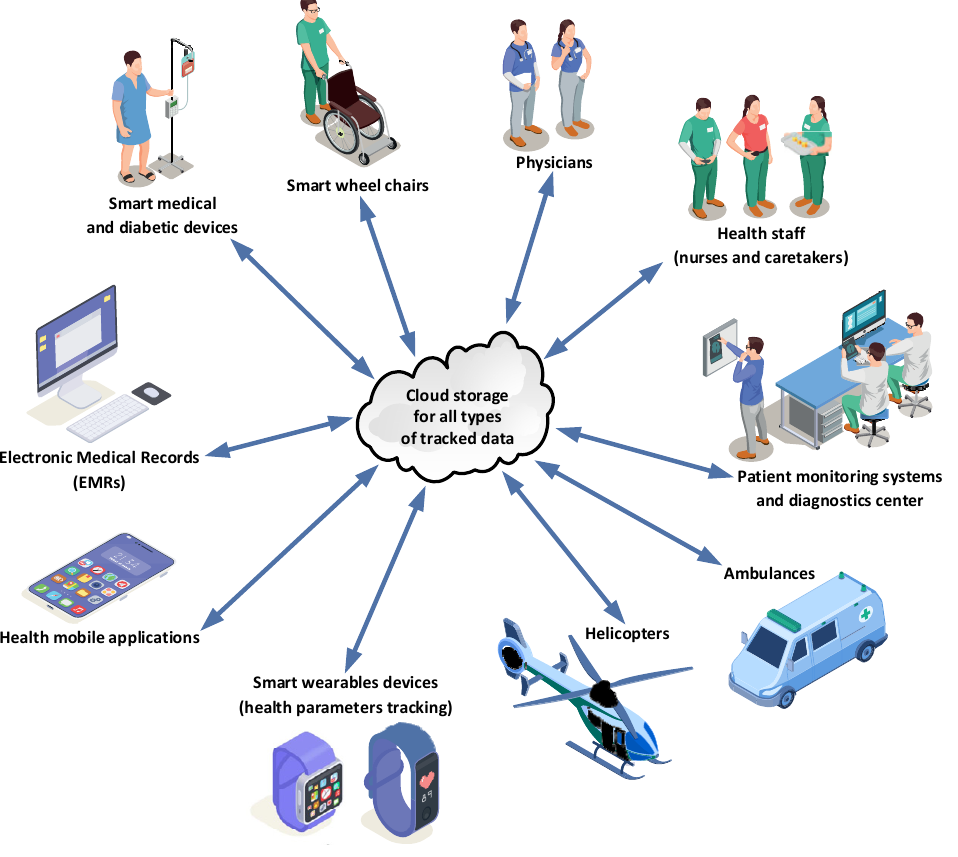
Figure 1. Cloud-based hospital application architecture in the present IoMT system.